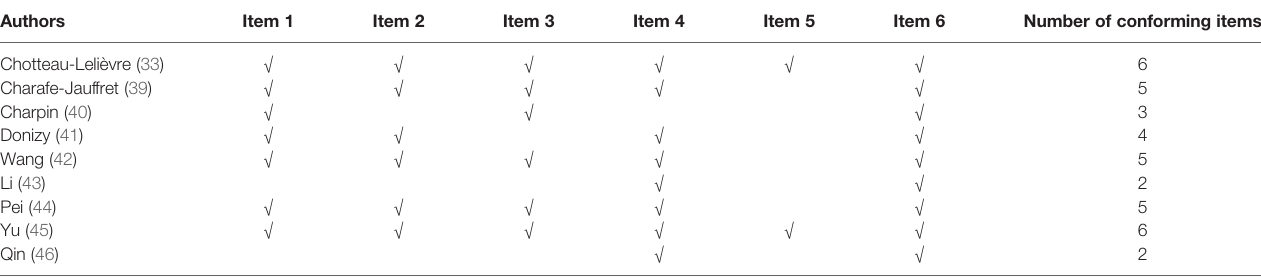
TABLE 2 | Evaluation criteria used to assess the quality of the